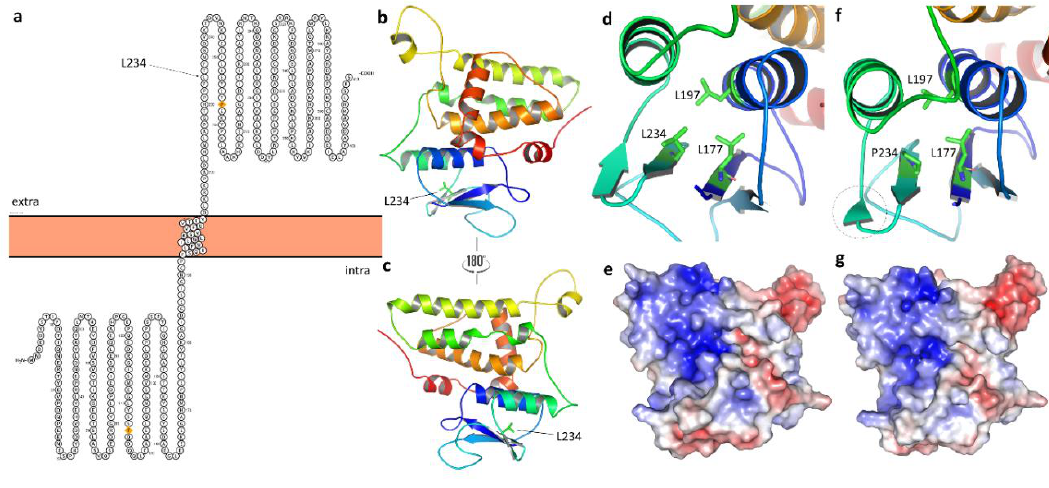
Figure 2. Evolutionary conservation of the CLIC5 :p.(L75P) variant position (indicated by the red arrow).